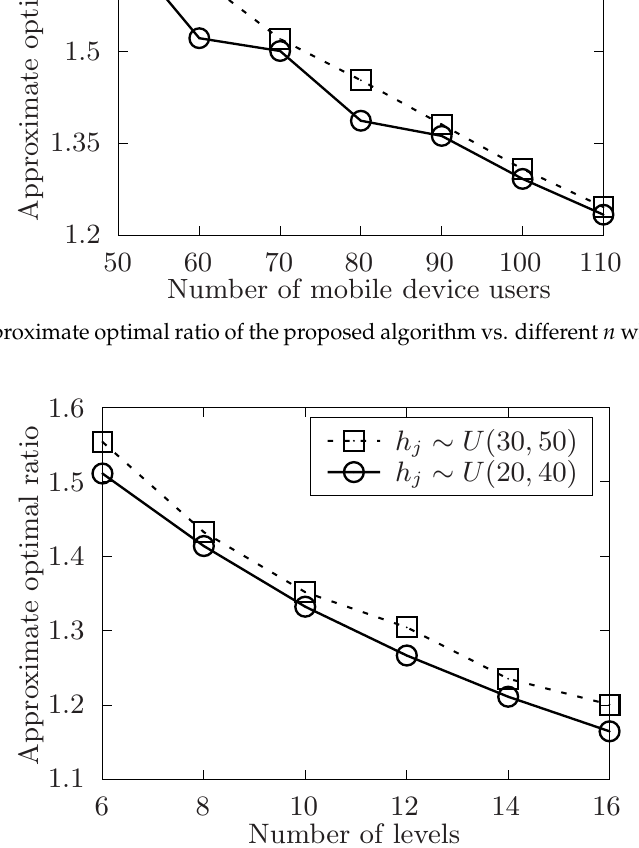
Figure 11. The approximate optimal ratio of the proposed algorithm vs. different l when h j ∼ U ( 20,40 ) or U ( 30,50 )